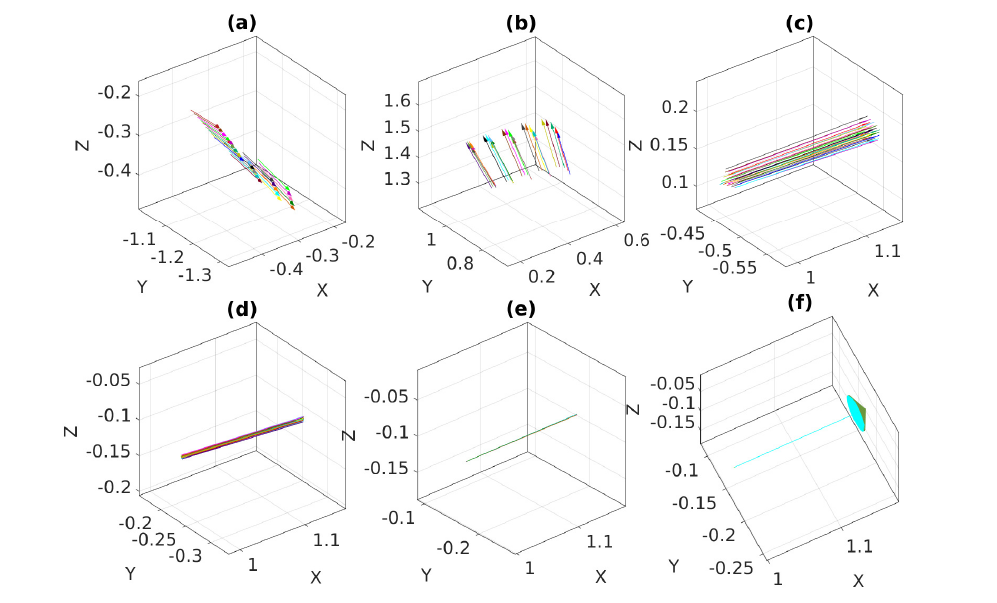
Figure 15. Optimization process of the proposed method with feature noise [0–0.15 pixel]: ( a ) Normal vectors at iteration 1; ( b ) Normal vectors at iteration 2; ( c ) Normal vectors at iteration 3; ( d ) Normal vectors at iteration 8; ( e ) Normal vectors at iteration 13; ( f ) Normal vectors at iteration 20